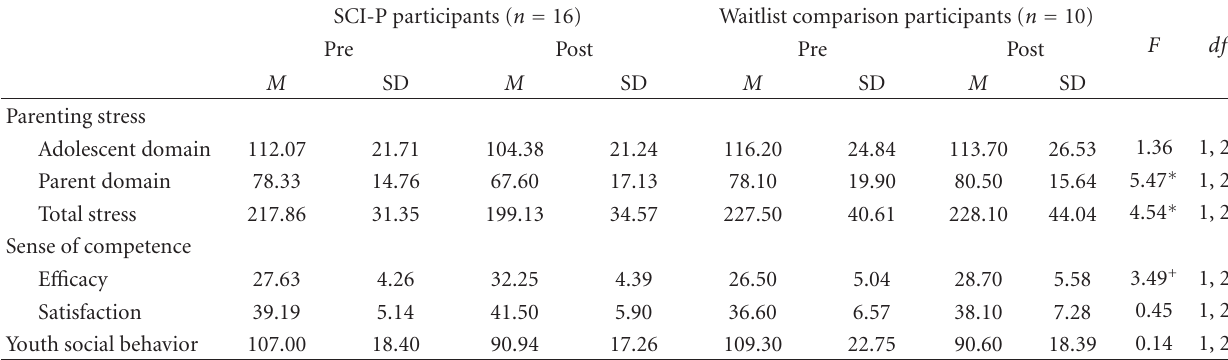
Table 2: Di ff erence in outcomes for SCI-P participants versus waitlist comparison